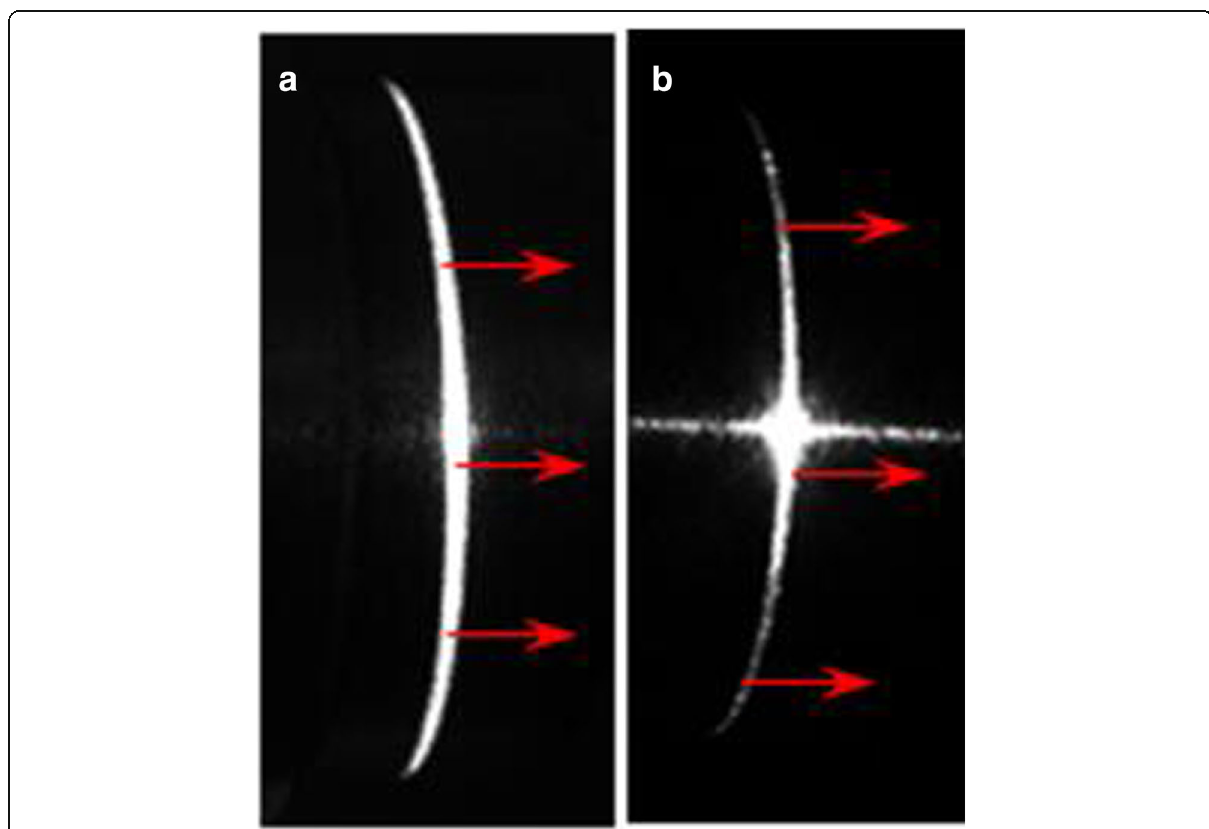
Fig. 6 Curved light bar image contrast. a Better quality light stripe image b Poor quality light stripe